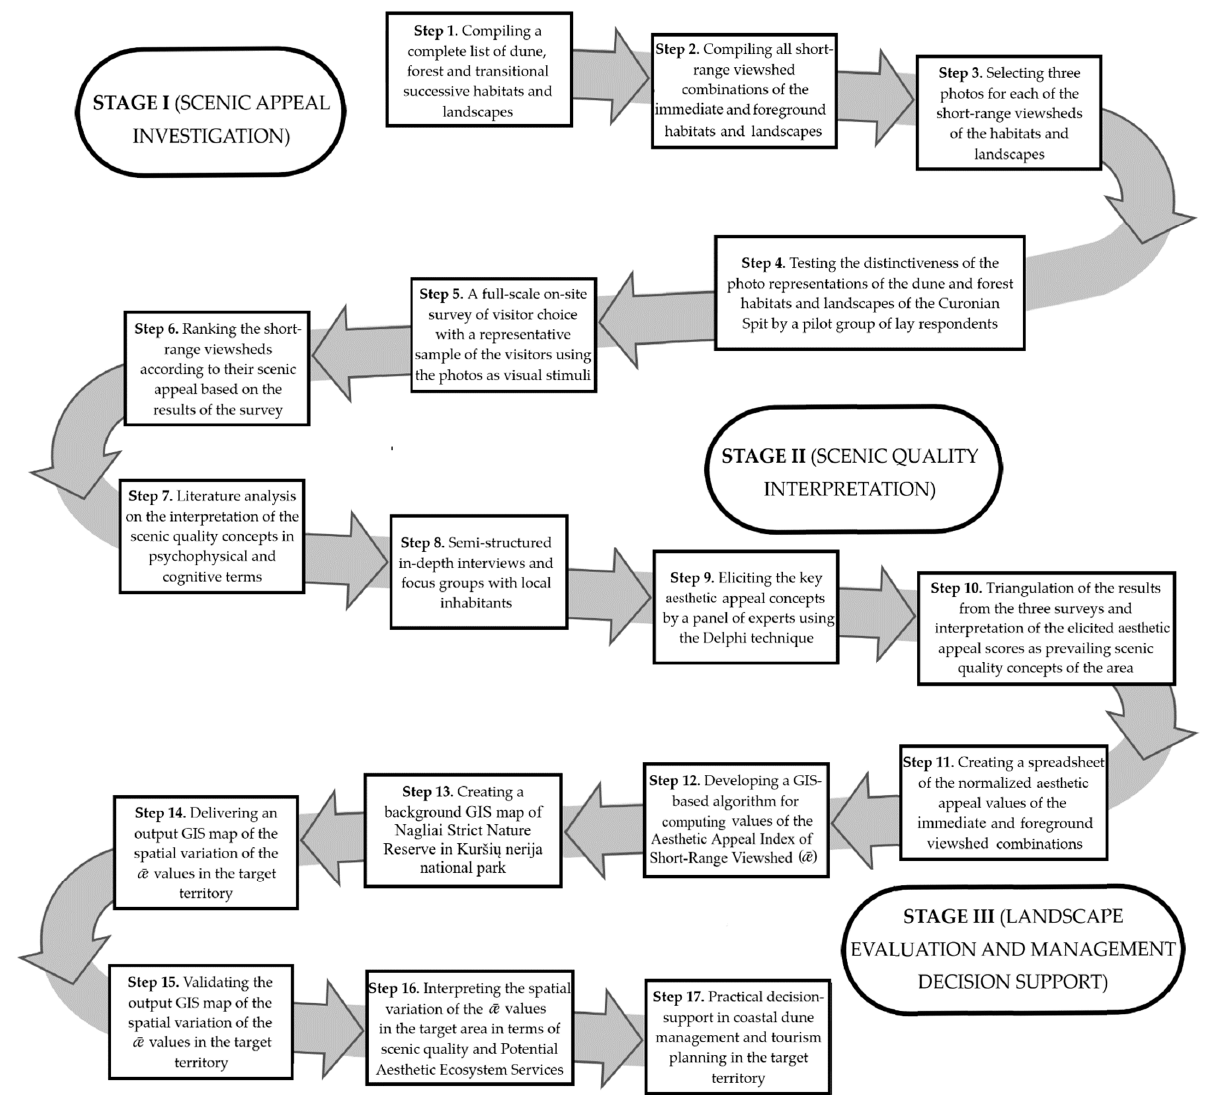
Figure 2. The flowchart of stages and steps of the whole research project. (Drawn by Arvydas Urbis).